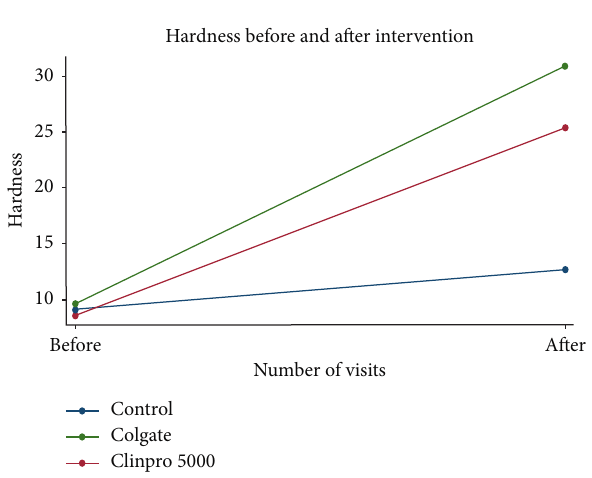
Figure 1: The surface microhardness before and after the